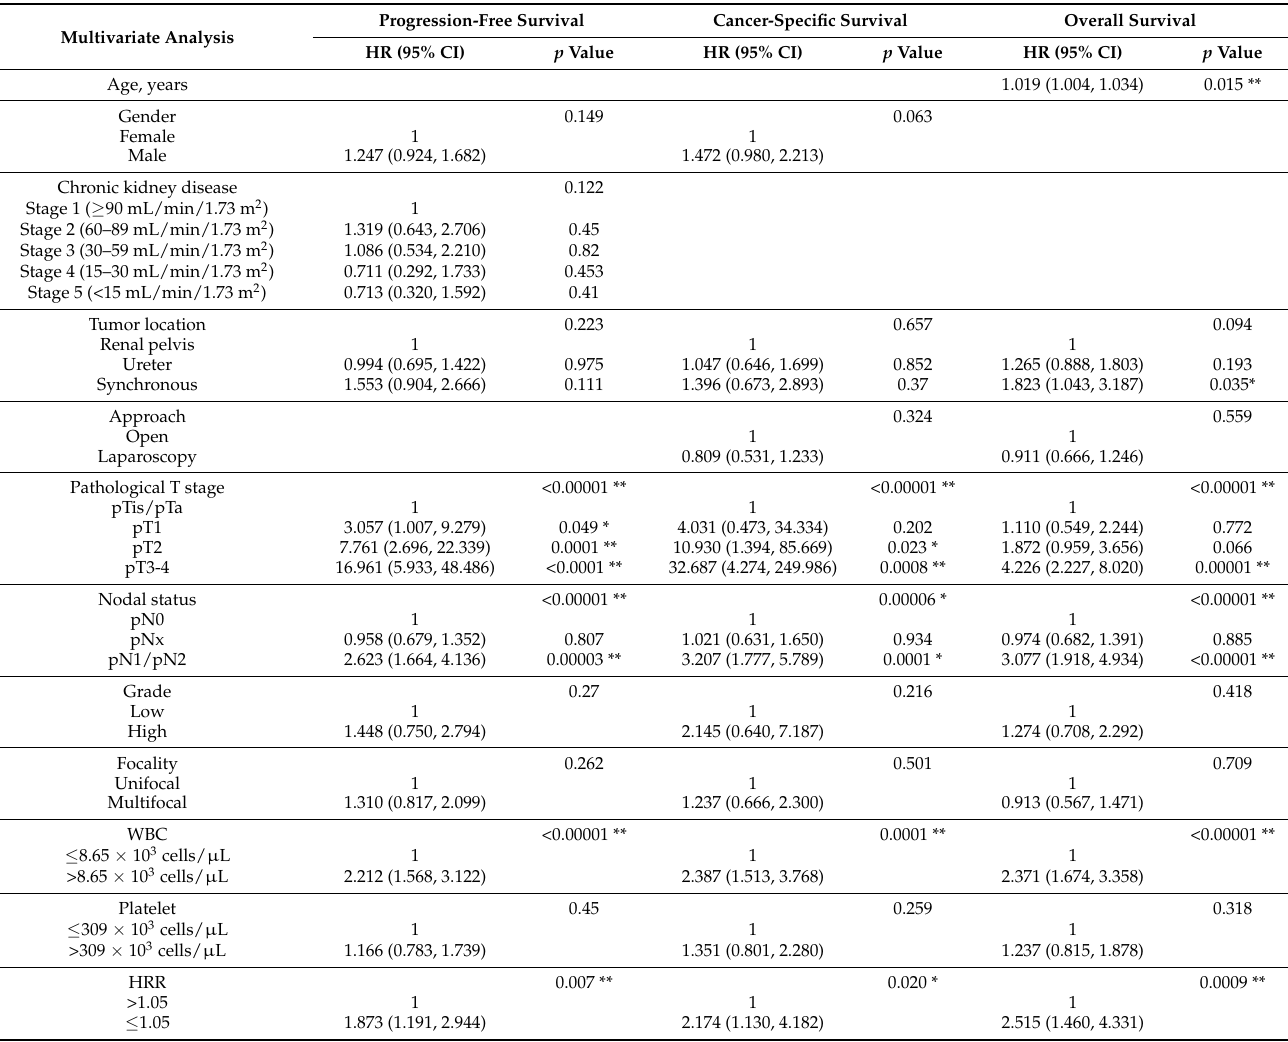
Table 3. Comparative multivariate survival analyses of 730 patients with upper tract urothelial carcinoma (UTUC). Progression-Free Survival Cancer-Specific Survival Overall Multivariate Analysis